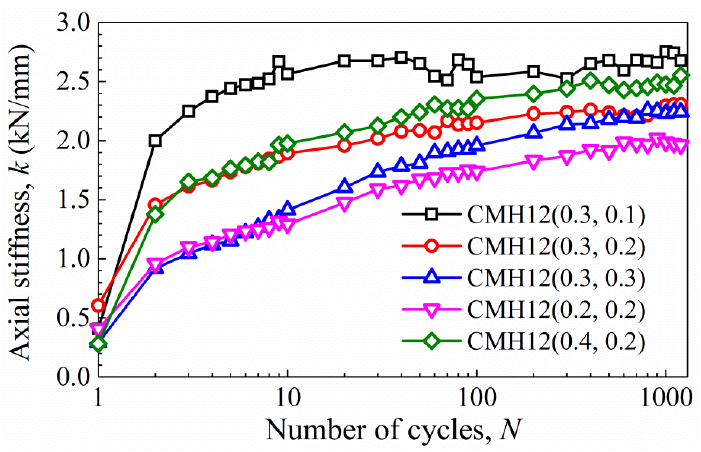
Figure 20. Development of axial stiffness under different amplitudes and mean cyclic loads.